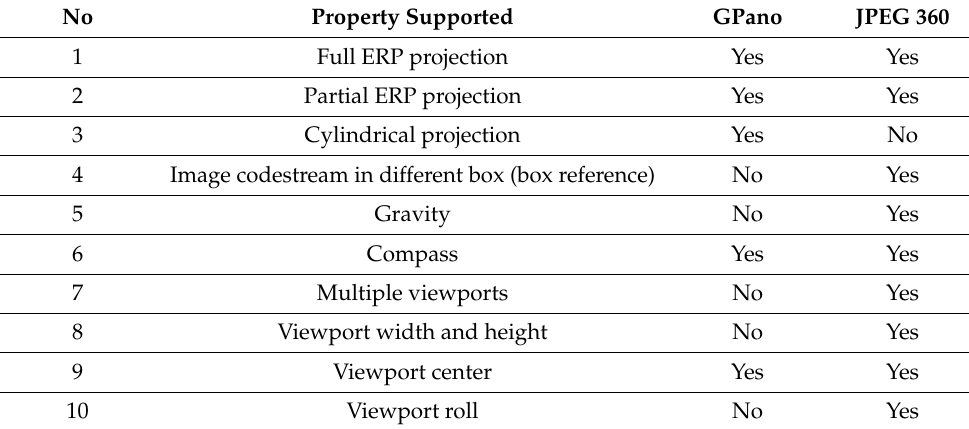
Table 6. GPano metadata and JPEG 360 properties